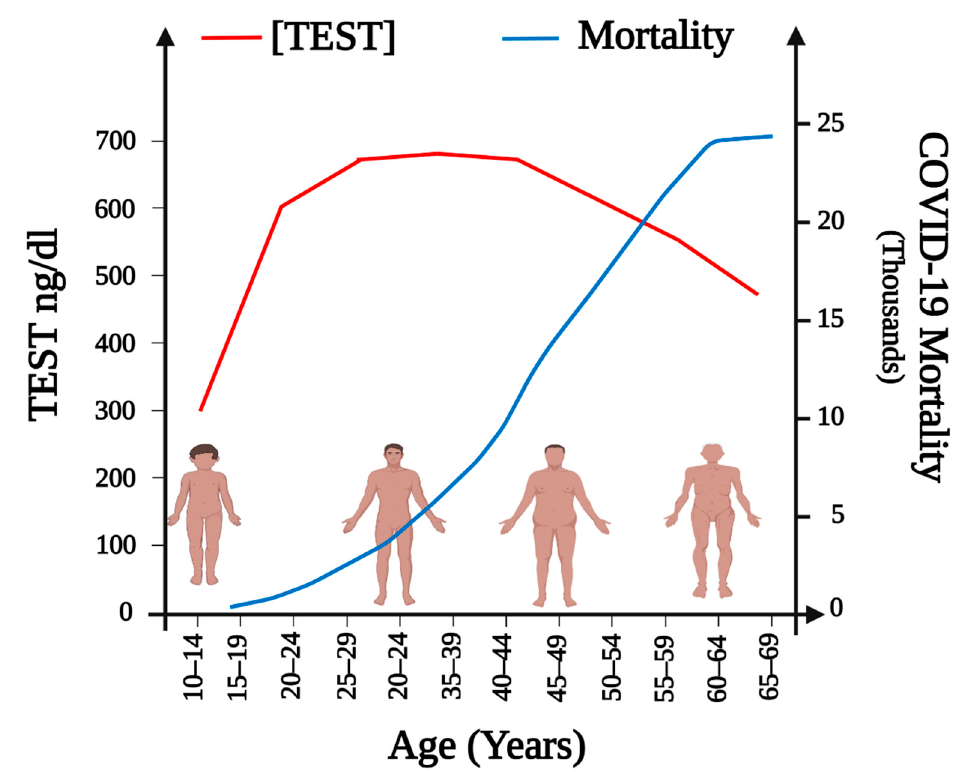
Figure 1. Association of TEST plasmatic concentrations and COVID-19 mortality in Mexican men by age group. Diminished TEST plasmatic concentrations have been associated with higher mortality by age group. In younger men TEST production could be affected during COVID-19 infection and lead to higher mortality. On the figure, the red line represents TEST plasmatic concentrations, and the blue line illustrates COVID-19 mortality in